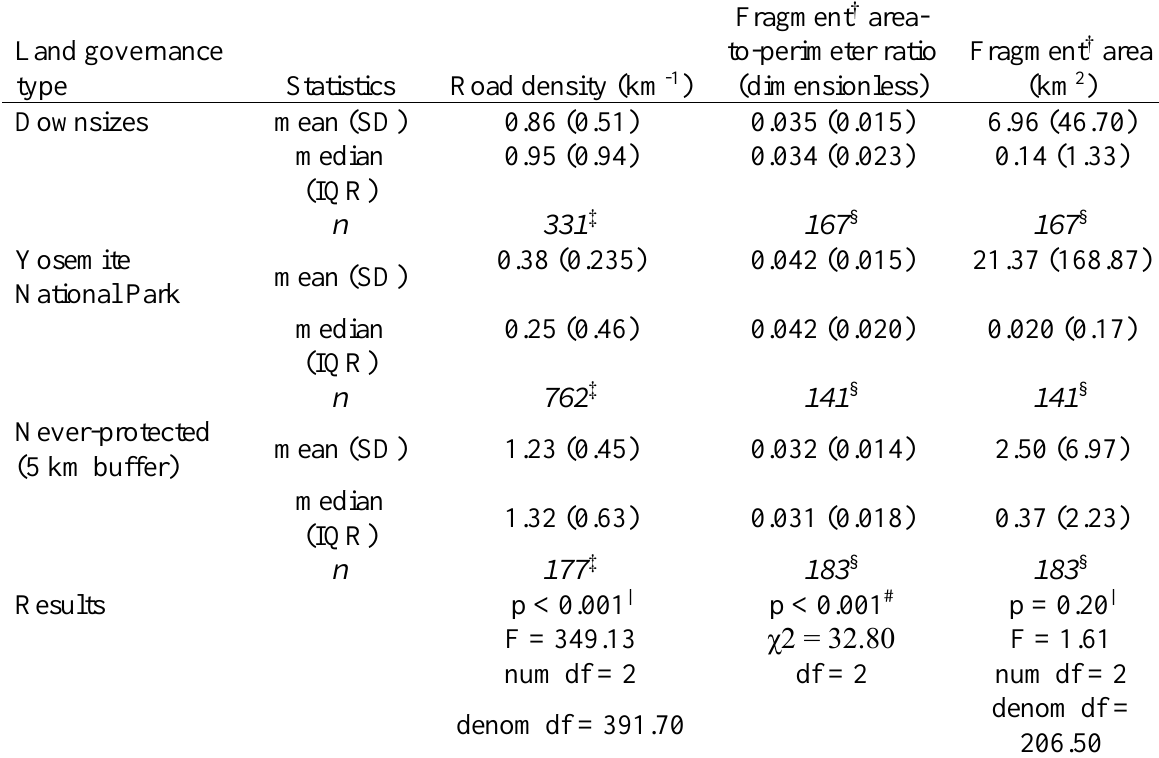
Table A1.1: Habitat fragmentation indicators at the Park scale for forested lands – sensitivity test using a 5 km never-protected lands buffer demonstrate the same results as with a 1 km buffer. See Table A1.2 for results of post-hoc